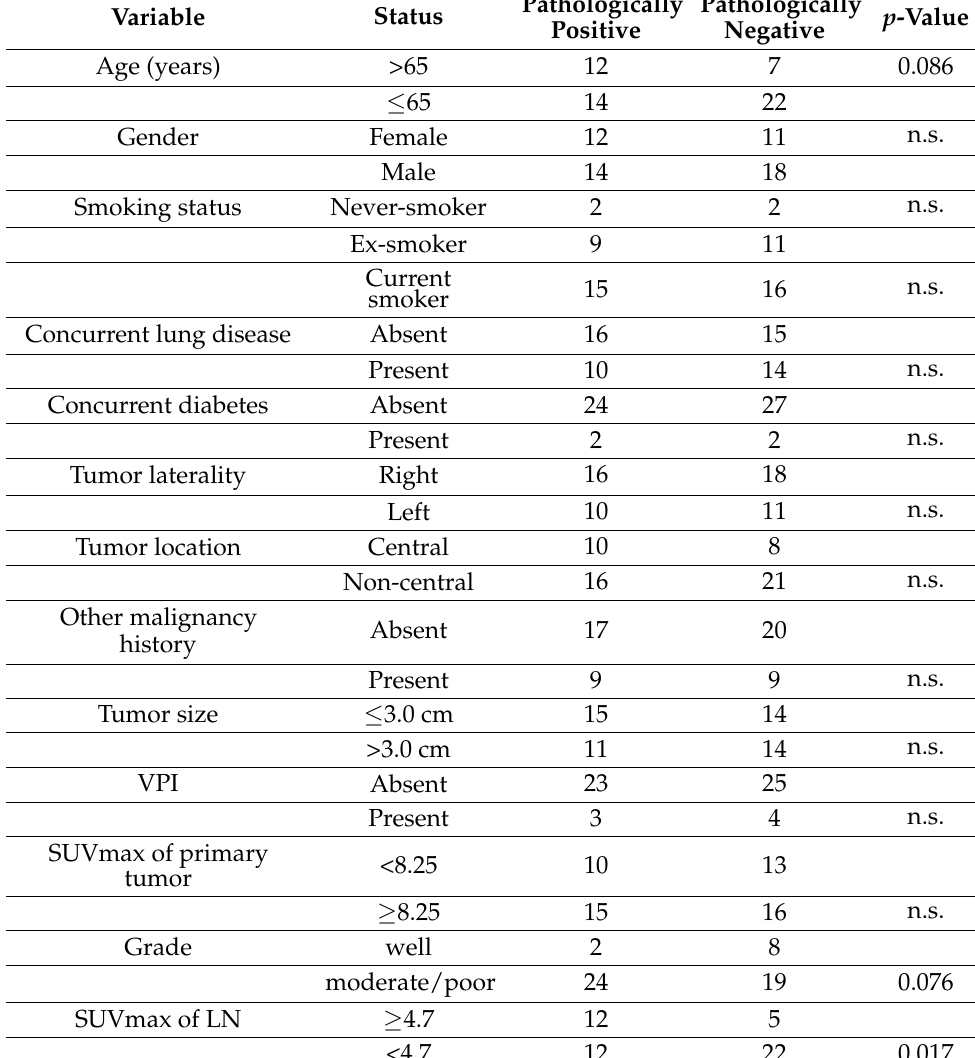
Table 6. Univariate analysis for factors associated with false positives in integrated 18F-FDG-PET/CT positive